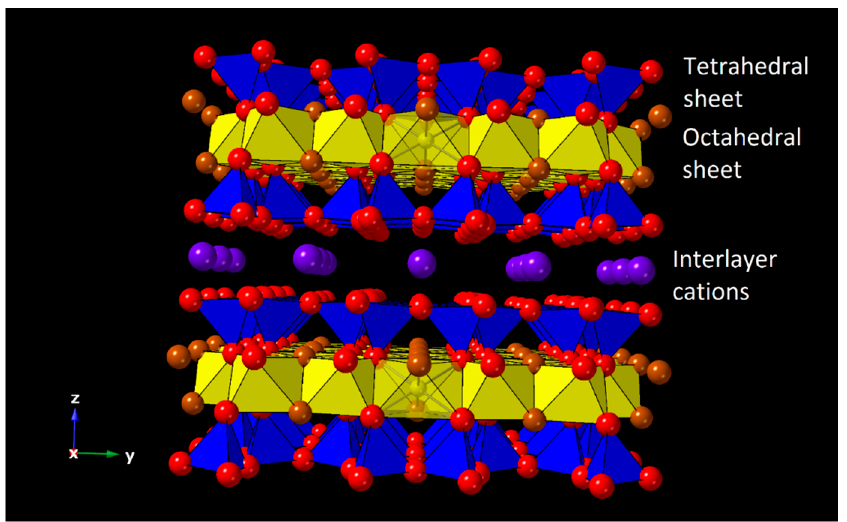
Figure 1. Ideal structure of saponites showing the tetrahedral (Si, Al) and octahedral (Mg) sheets and interlayer space with interlayer cations (Na, K, Ca,